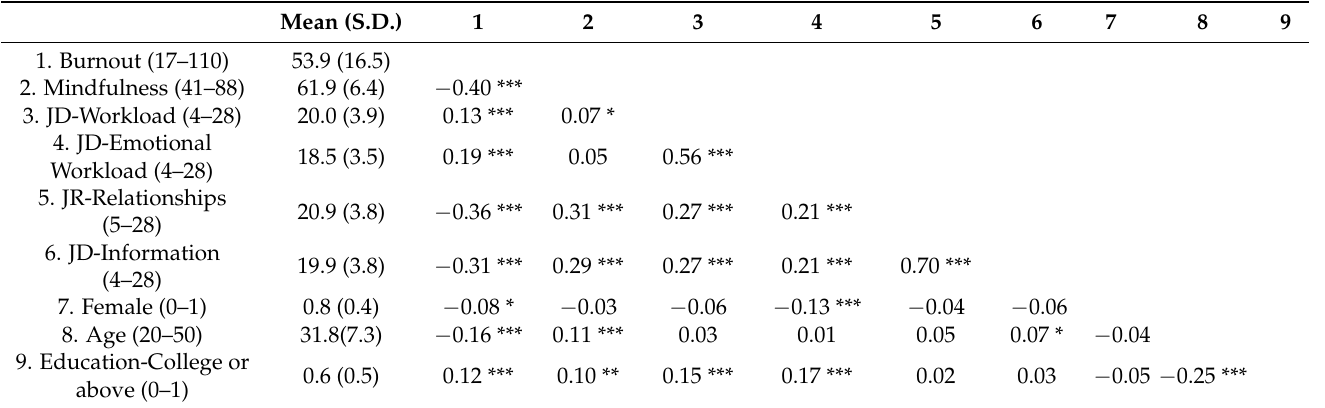
Table 1. Descriptive Statistics and Correlations of Key